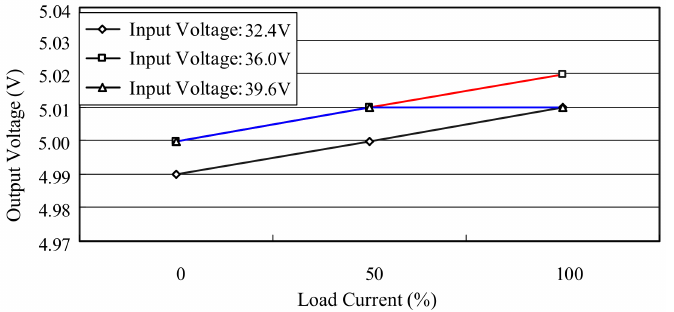
Figure 30. Curve of first secondary output voltage versus load current on condition that the main and second secondary outputs are located at rated load.